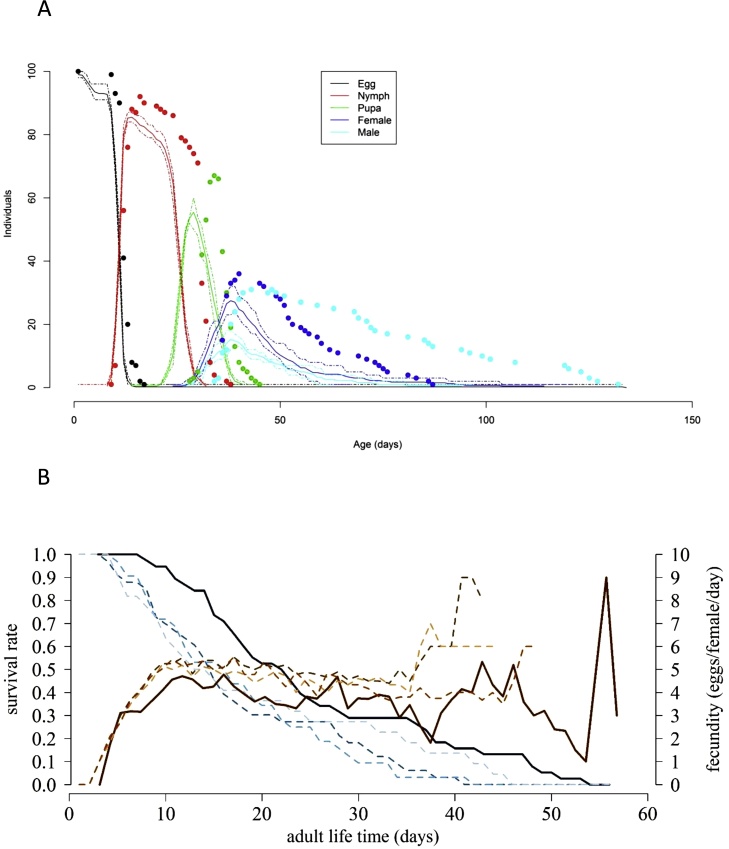
Comparison of life table results obtained for T. vaporariorum in Cusco (first life table) with outputs of four stochastically simulated life tables. A) Age-stage specific survival rates; dots are observed data of indicated life stages, lines are stochastic simulation outputs (full line: average of four life table simulations; scattered lines: minimum and maximum values obtained from the four simulations). B) Age-specific survival rates (blue lines) of adult females and fecundity (brown lines; full lines: observed data, scattered lines: results obtained from four stochastically simulated life tables).